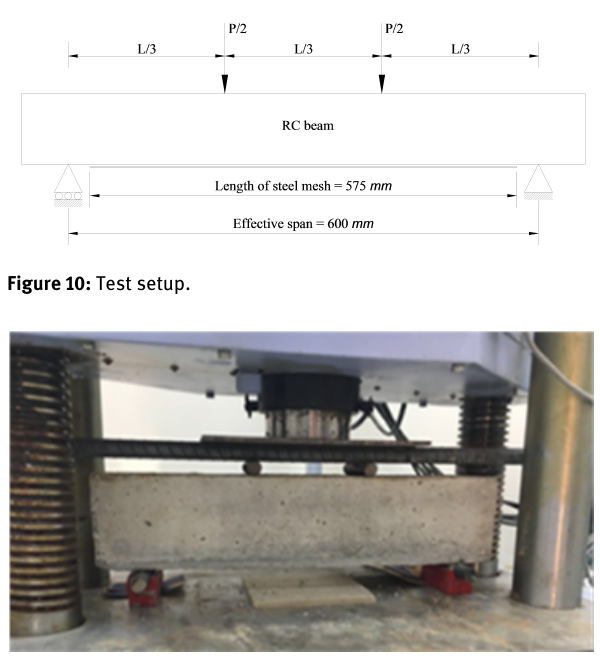
Figure 11: Load setup.